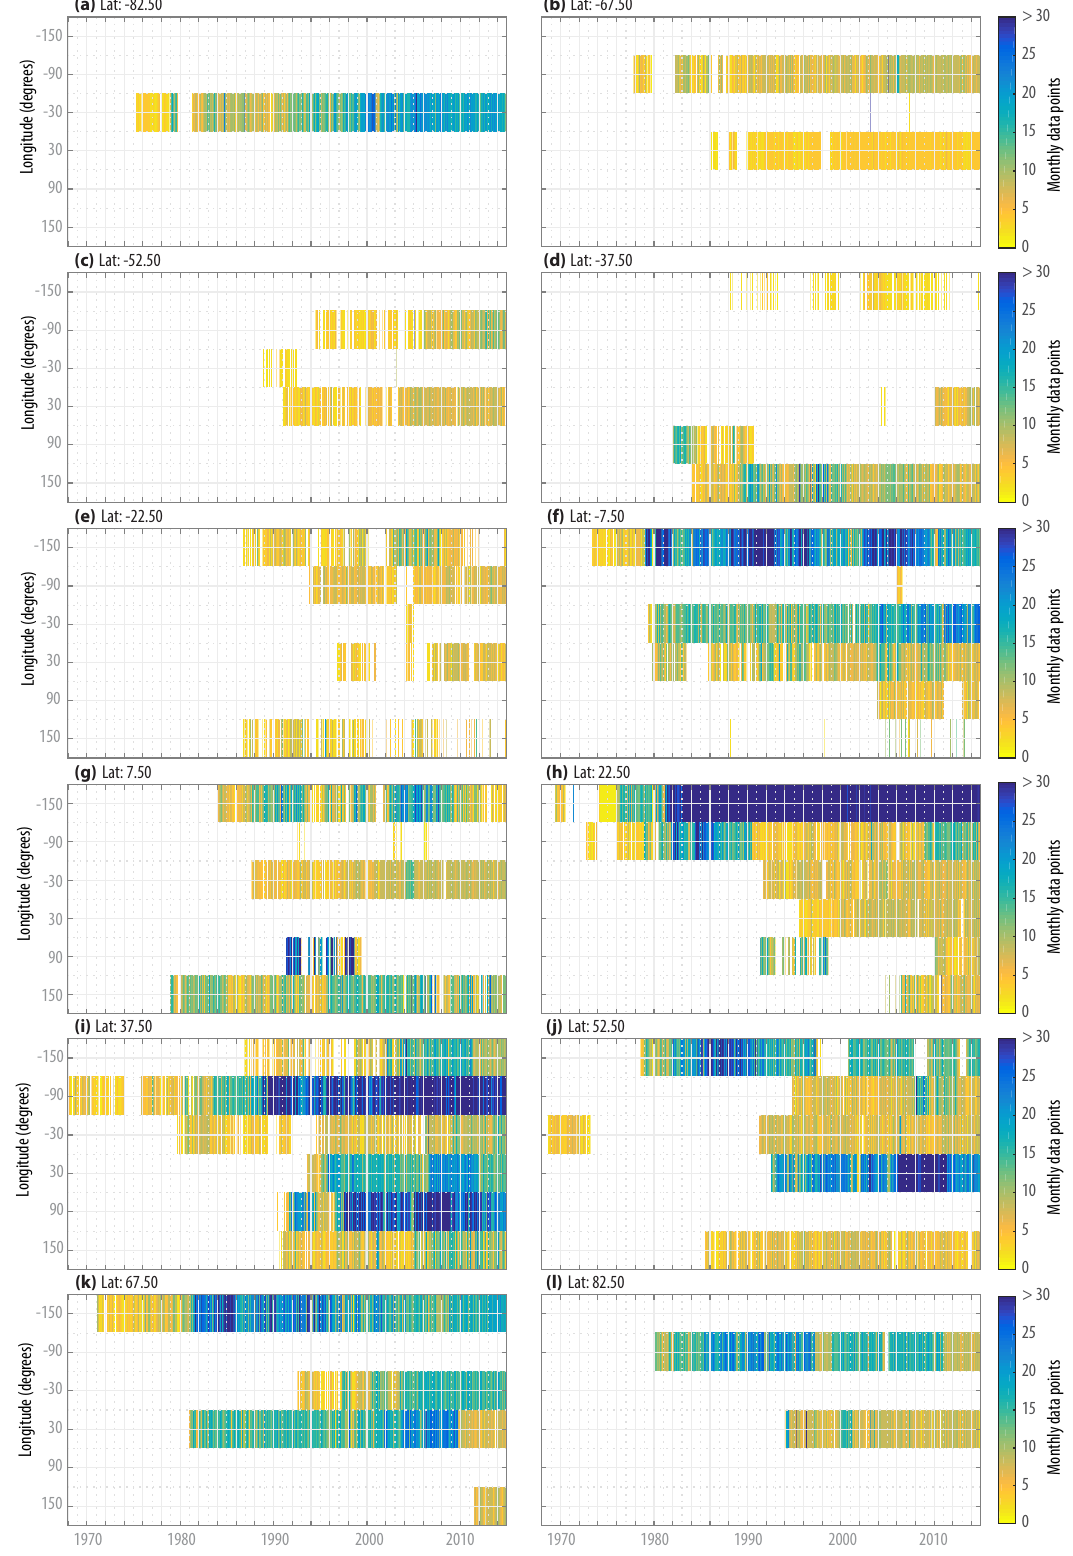
Figure 2. Availability of instrumental carbon dioxide data from 1968 to 2015 from the NOAA ESRL network, shown as data samples per month, per latitudinal band (a–l) and per longitudinal bin within each latitudinal